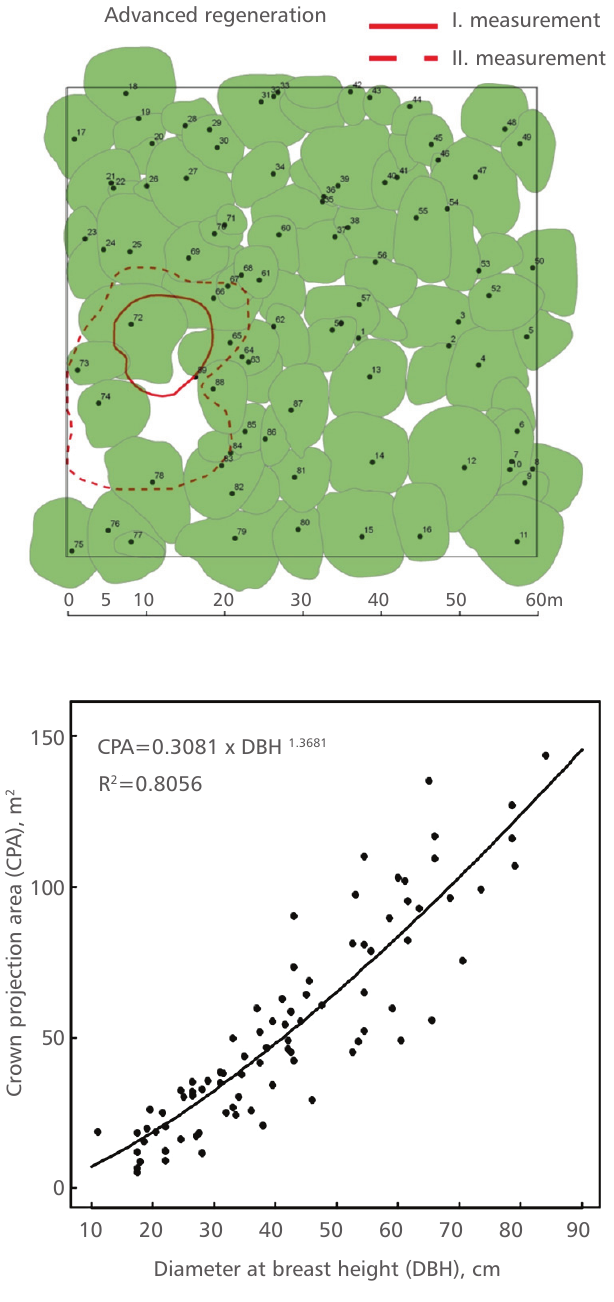
FIGURE 3. Horizontal projections of crowns (first measurement 1998) with advanced regeneration (1998 full line, 2009 broken line)